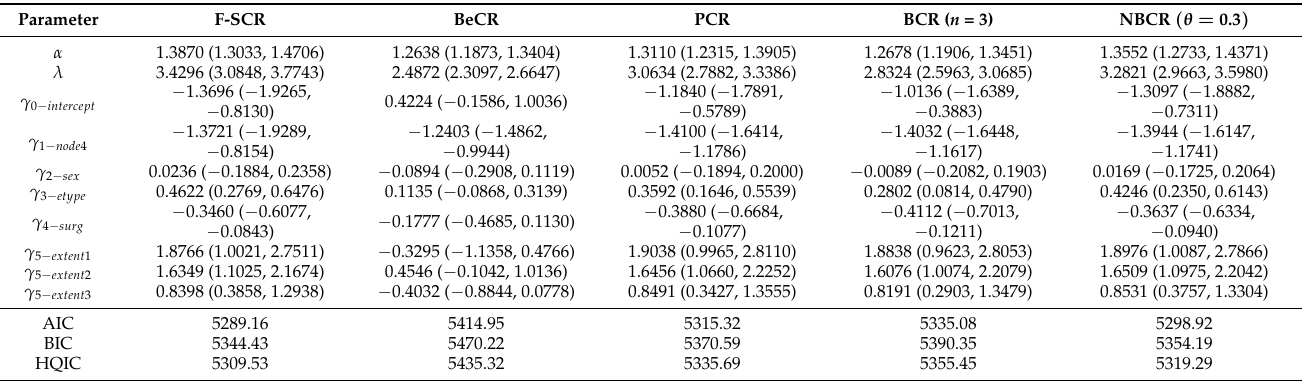
Table 3. ML estimators (95% confidence intervals) and information criteria for the colon cancer data set based on Weibull